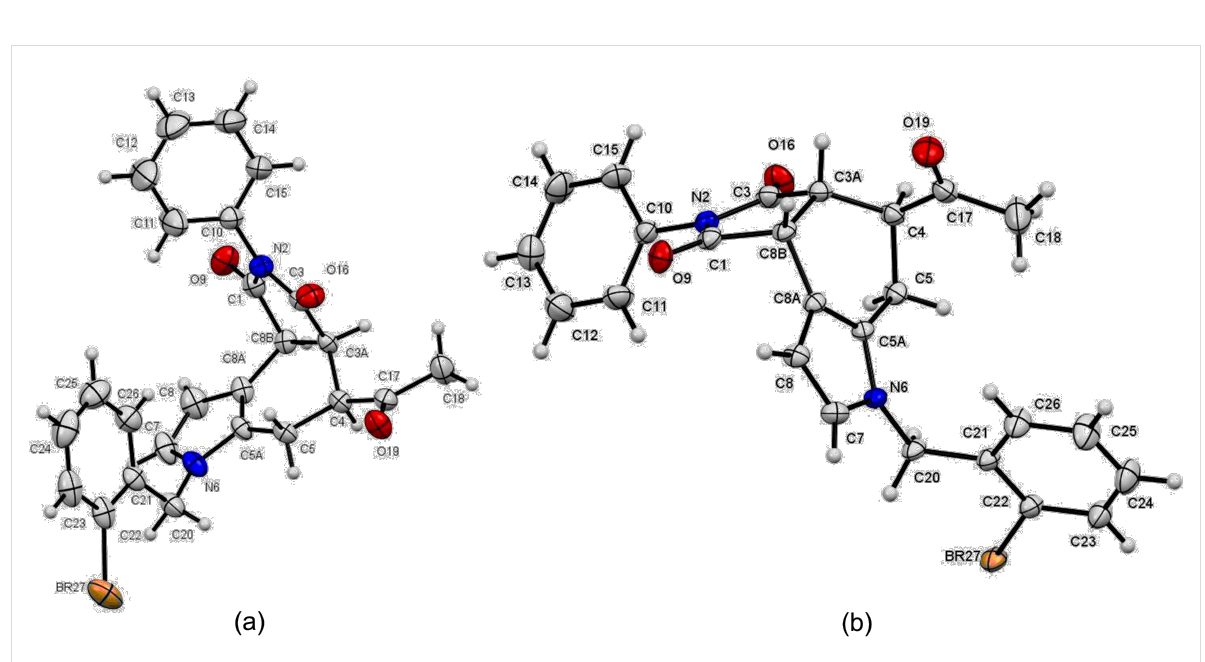
Figure 2: Structures of 9m (a) and 10m (b) as determined by single-crystal X-ray diffraction crystallography (ellipsoids at the 30% probability level).